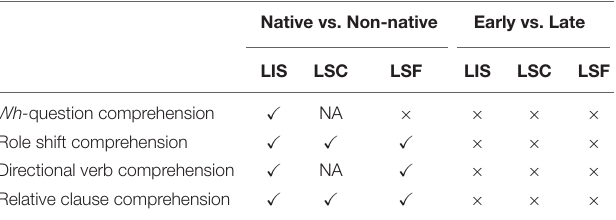
TABLE 4 | Summary of the SIGN-HUB tests where native signers significantly outperformed non-native and where early learners significantly outperformed late learners in at least one condition of the